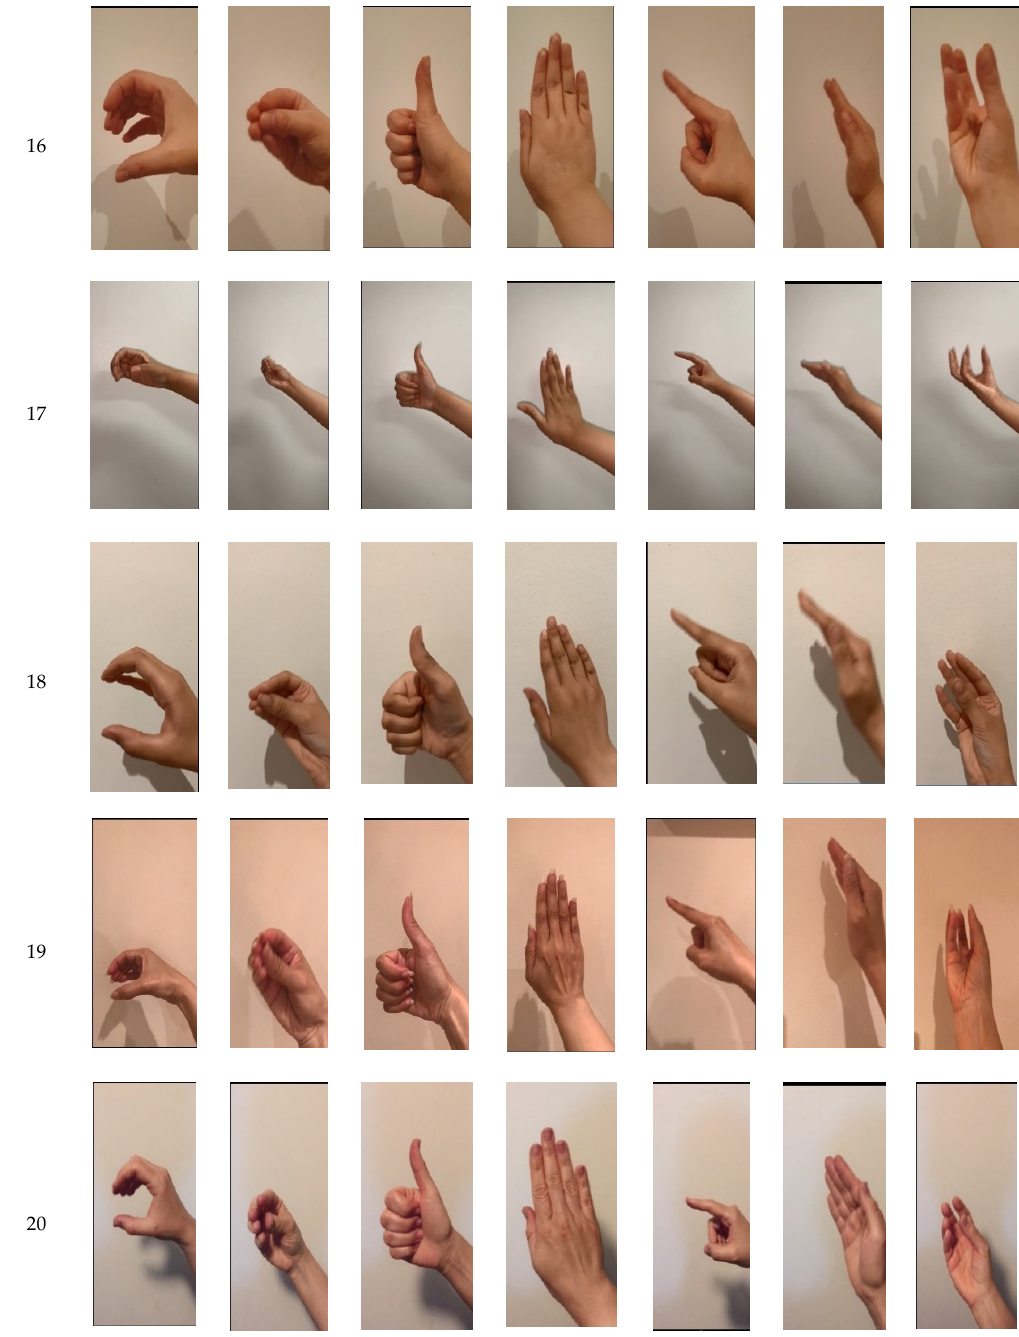
Figure A2. Seven hand motions for the remaining seventeen subjects.